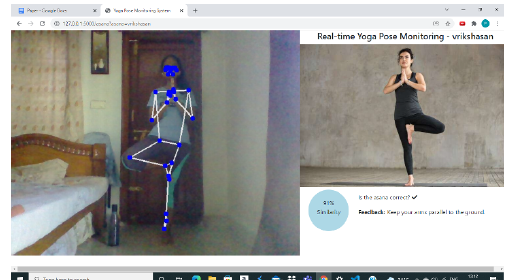
Figure 14. Front-end.